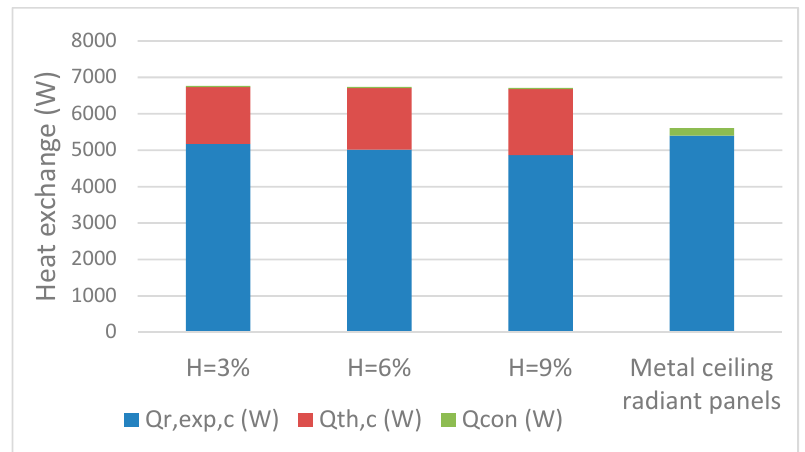
Figure 5. The comparison between the RIDUs (6 × 8 m 2 ) and the traditional plate-type radiant panel.